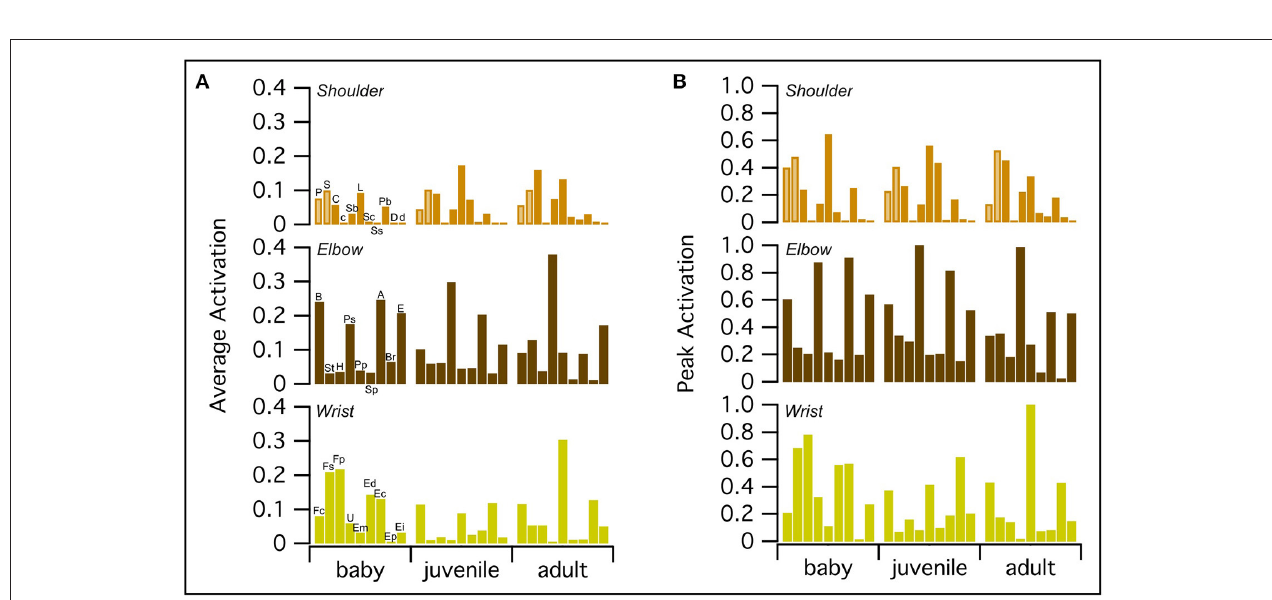
FIGURE 6 | Peak and average muscle activations. On average, baby, juvenile, and adult chukars have similar levels of muscle activation (A) , though the baby chukar has slightly higher peak activations than the juvenile, which has slightly higher peak activations than the adult (B) . For all age classes, elbow and wrist muscles have higher average and/or peak activations than shoulder muscles, which have relatively low activations (generally < 0.5) ( Table S7 ). Each bar represents one muscle. The pectoralis and supracoracoideus are distinguished by lighter brown coloring in the top rows. P, Pectoralis; S, Supracoracoideus; C, Coracobrachialis posterior; c, Coracobrachialis anterior; Sb, Subcoracoideus; L, Latissimus dorsi; Sc, Scapulohumeralis caudalis; Ss, Subscapularis; Pb, Propatagialis brevis; D, Deltoideus major; d, Deltoideus minor; B, Biceps brachii; St, Scapulotriceps; H, Humerotriceps; Ps, Pronator sublimis; Pp, Pronator profundus; Sp, Supinator; A, Anconeus; Br, Brachialis; E, Entepicondyloulnaris; Fc, Flexor carpi ulnaris; Fs, Flexor digitorum sublimis; Fp, Flexor digitorum profundus; U, Ulnimetacarpalis ventralis; Em, Extensor metacarpi radialis; Ed, Extensor digitorum communis; Ec, Extensor carpi ulnaris; Ep, Extensor pollicis longus; Ei, Extensor indicis longus.